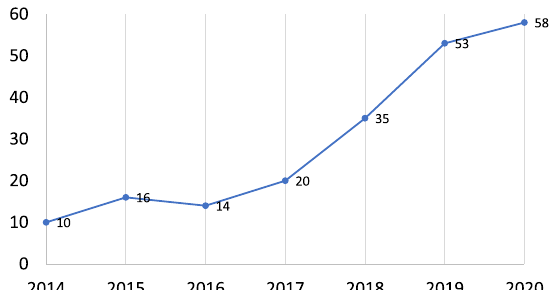
(Table 1). Of 172 papers using secondary data analysis, 44